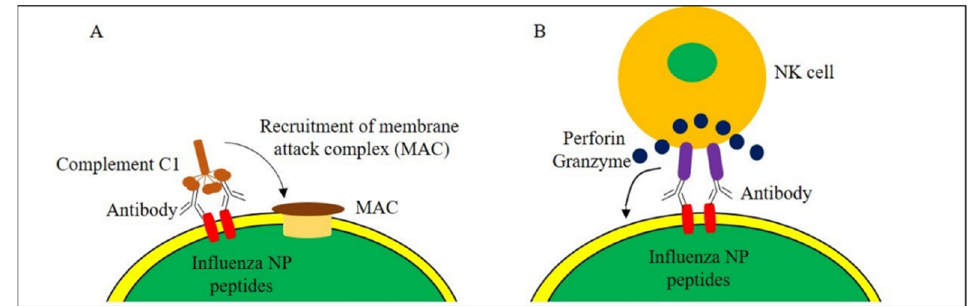
Figure 3. Complement- and antibody-mediated cytotoxicity in influenza virus-infected cells. ( A ) Binding of antibodies to NP peptides on the cell surface recruits complement factors to form membrane attack complex (MAC) on the cell membrane and induce cell lysis. ( B ) On the infected cell surface, NK cells bind to NP-specific antibodies and induce cell death via perforin and granzyme.